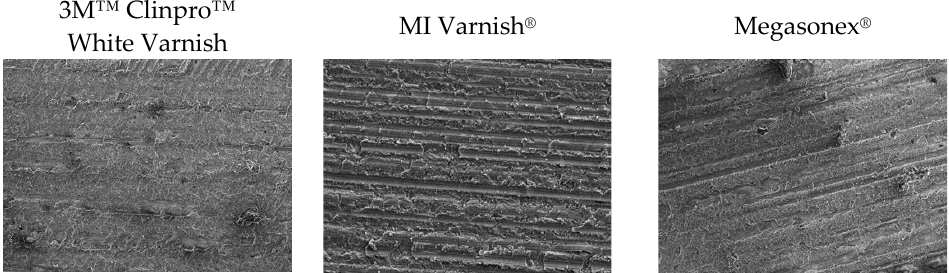
Figure 2. Representative SEM images (accelerating voltage of 5 kV, working distance of 10 mm, magnification of 500×) of the sample surfaces after remineralization.